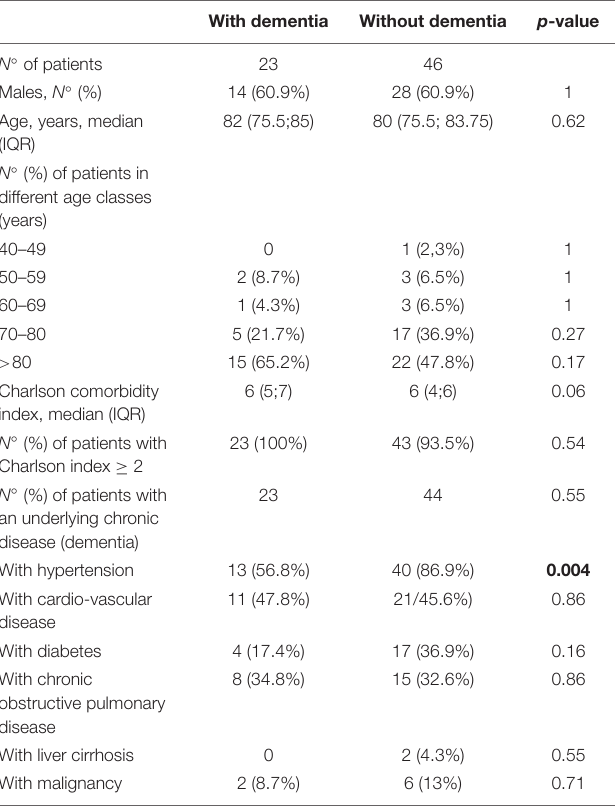
TABLE 3 | Clinical presentation of coronavirus disease 2019 (COVID-19) in case and control groups. With dementia Without dementia p